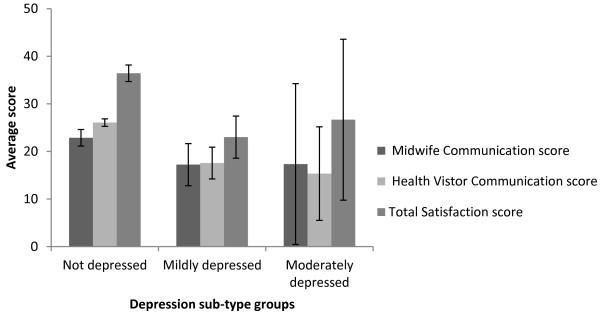
Mean total satisfaction with postnatal care and communication ratings grouped by depression sub-types. Error bars represent standard errors.